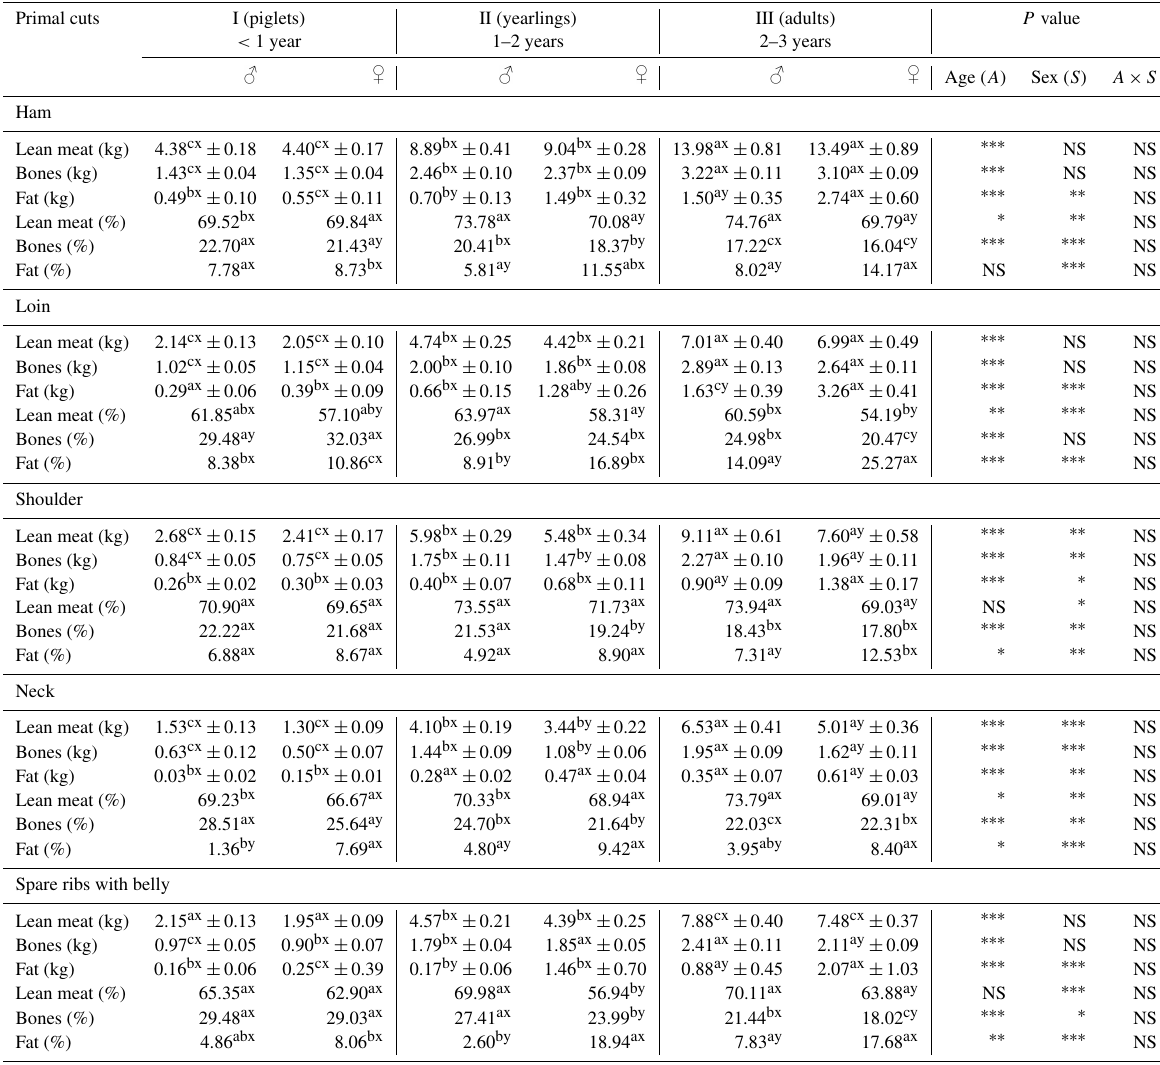
Table 3. Tissue composition of primal cuts of boar carcasses in weight and percentage with respect to the cut weight (mean ± SE). Primal